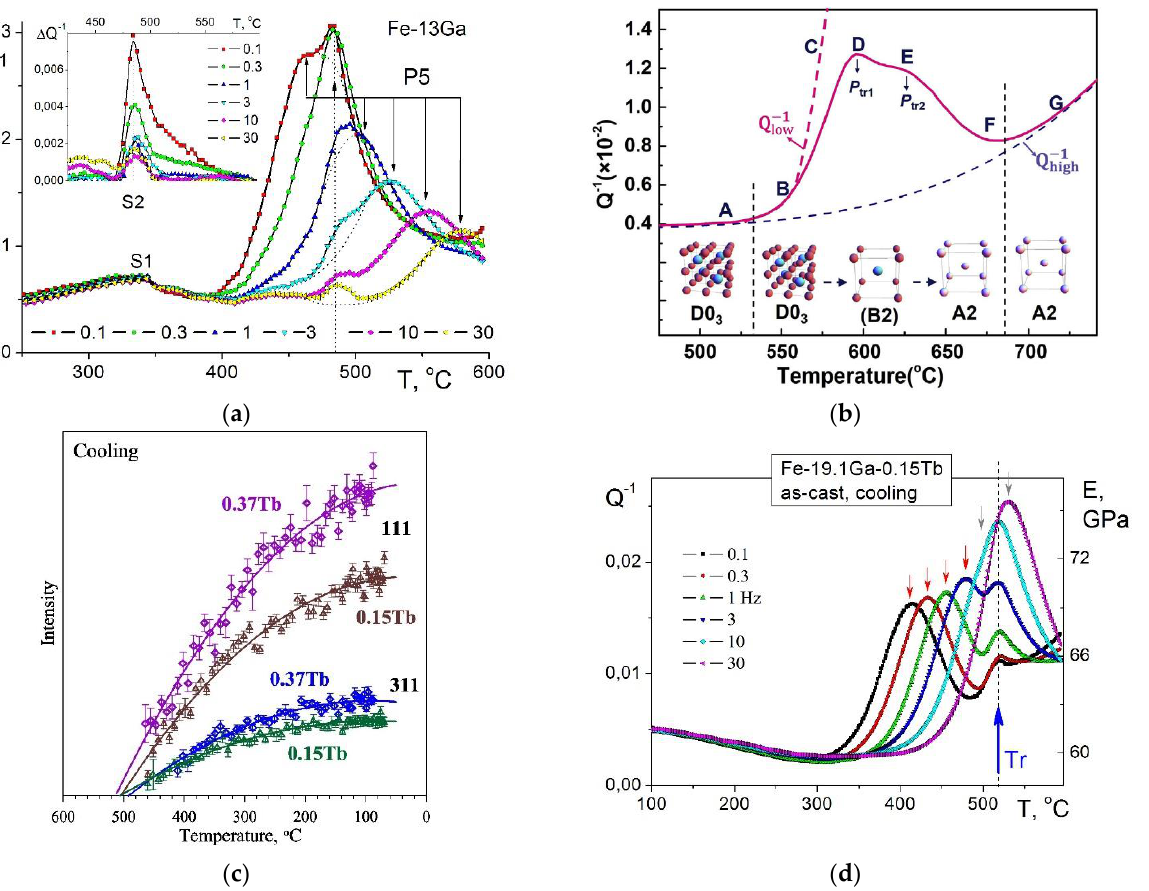
Figure 7. ( a ) Transient (S2) and Zener (P5) IF peaks in Fe–13Ga [30]; ( b ) transient IF peaks (D and E) in Fe–18.3Ga [119]; ( c ) in situ neutron diffraction data suggesting order–disorder transition at ~500 °C (at cooling with 2 K/min); and ( d ) TDIF (cooling with 2 K/min) curves with corresponding PTr peak at ~510 °C [48].